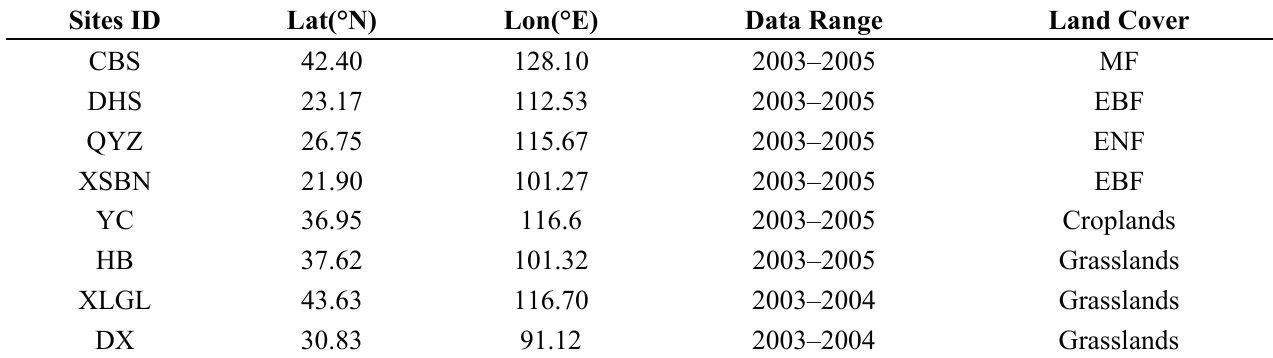
Table 1. A brief description of eight flux sites in this